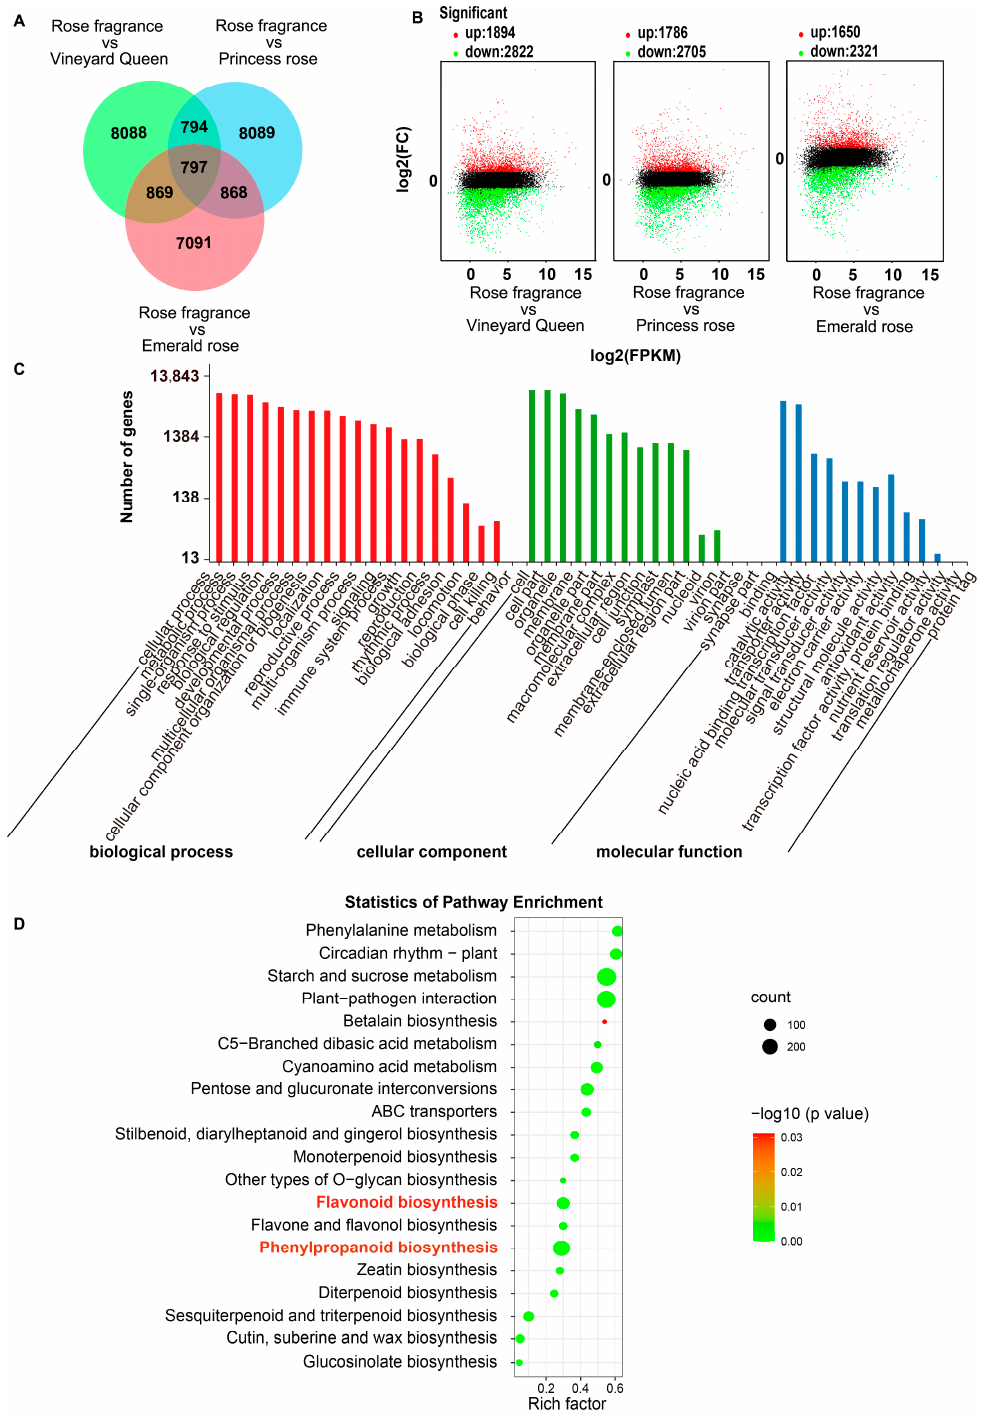
Figure 2. Summary statistics for grape transcription group data. ( A ) Venn graph shows the number of genes and relationships that differ in the comparisons. ( B ) MA plots for three comparisons. ( C ) GO enrichment regarding the biological processes, cellular components, and molecular functions. ( D ) Statistics of pathway enrichment.